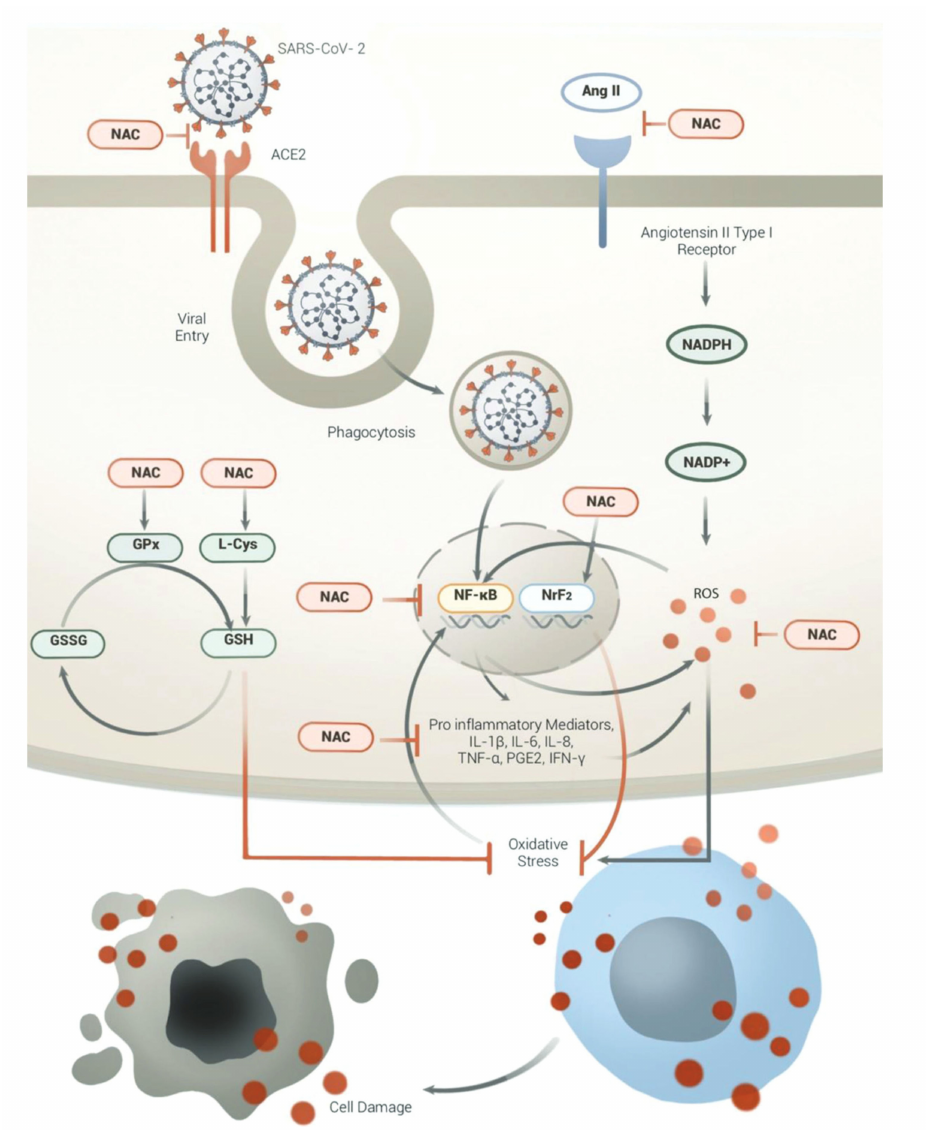
Figure 4. Possible mechanisms of NAC acting as antioxidant and anti-inflammatory agents in SARS- CoV-2 infection. Reproduced under the terms of the Creative Commons Attribution License. Elhidsi, M., Fachrucha, F., & Yudha Irawan, R. (2021). N-Acetylcysteine for COVID-19: A Potential Adjuvant Therapy. Journal of Health Sciences, 11(1), 1–6.